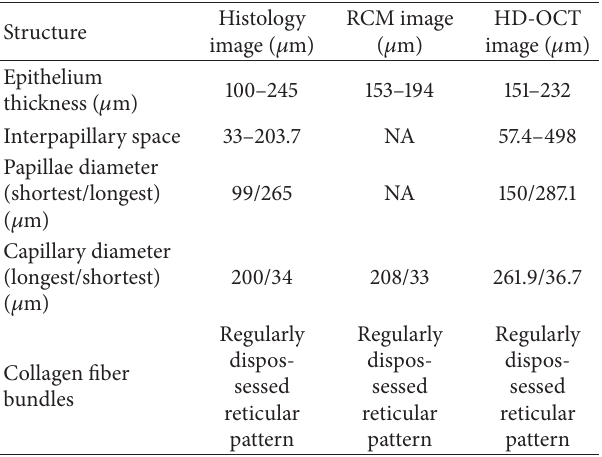
Table 5: Mean measurements of cellular and morphologic features in lower lip mucosa in vivo by reflectance confocal microscopy and high-definition optical coherence